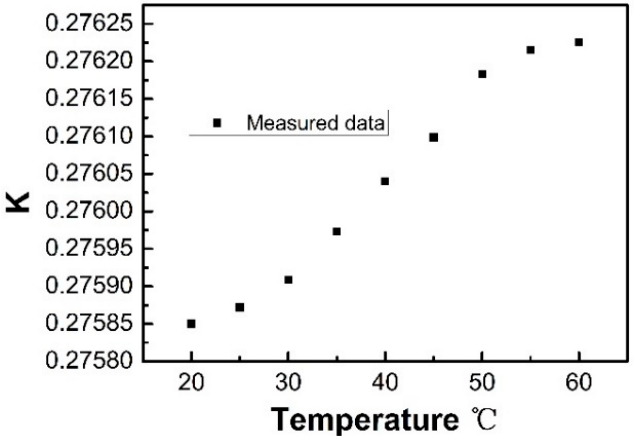
Figure 8. The temperature influence of the sensor in water, where the active and passive fiber diameters were 100 and 200, respectively, and the twisted region length was 12 mm.